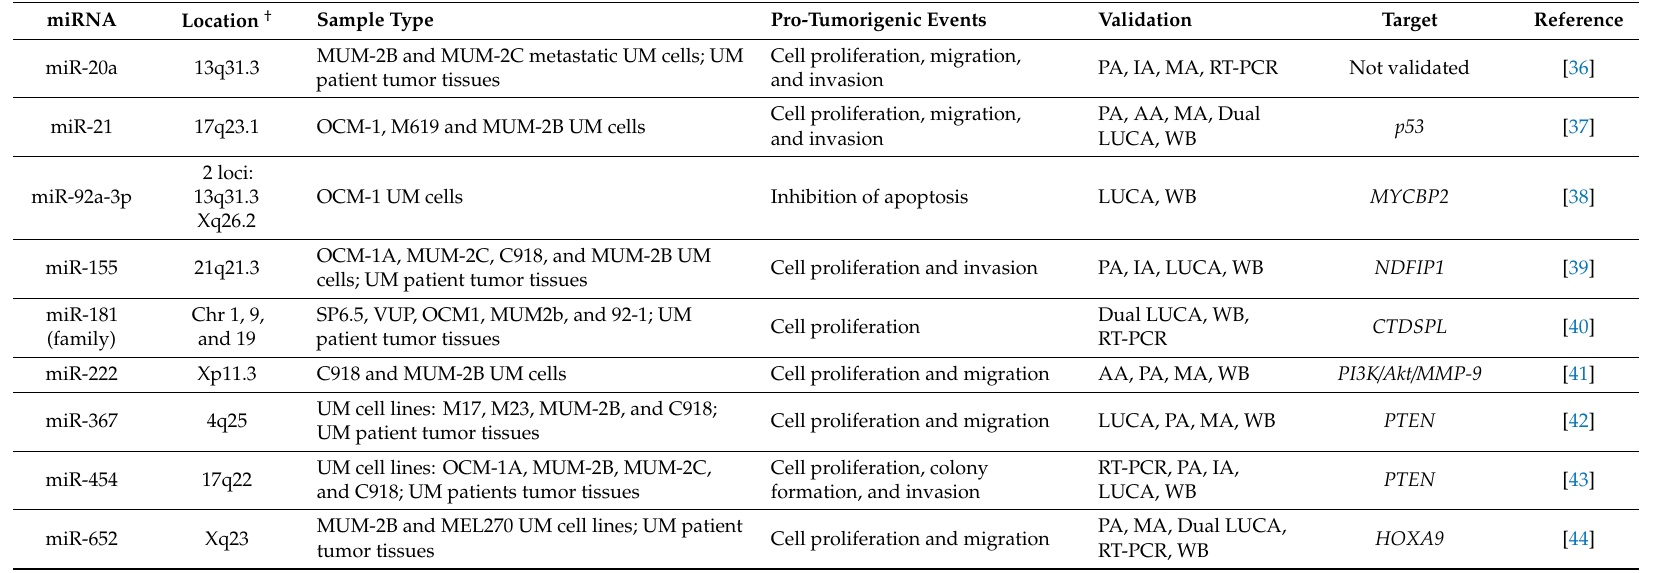
Table 2. miRNAs with oncogenic action. A description of known miRNAs with oncogenic role in UM is shown indicating their chromosomal location, cell / tissue where it was described, their tumor promoting e ff ect, gene target, existence of experimental validation, and reference. A summary indicating the main characteristics of the UM cell lines mentioned in this table are shown in Table S1